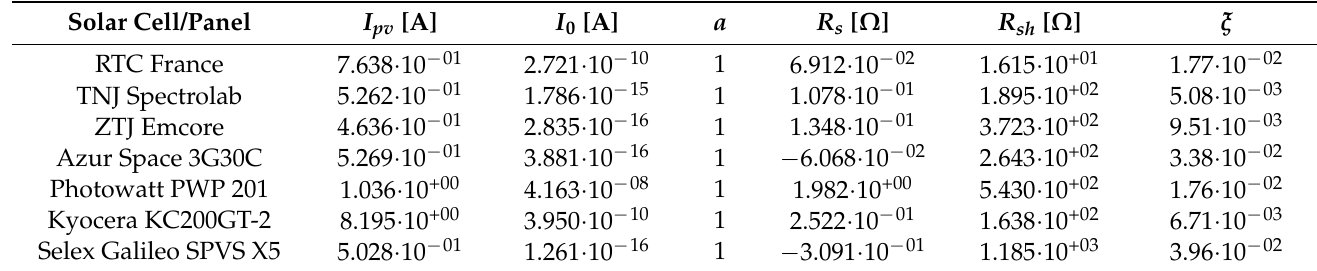
Figure 7. Values for the non-dimensional RMSE, x , obtained from a numerical fit of the 1-D/2-R equivalent circuit model to the studied I-V curves (see Table 2), an analytical fit (see Table 3), and an analytical fit with a = 1 (see Table 4). Table 4. Analytically fitted parameters for 1-D/2-R equivalent circuit models, with a = 1, for I-V curves corresponding to RTC France, TNJ Spectrolab, ZTJ Emcore, and Azrur Space 3G30C solar cells, and Photowatt PWP 201, Kyocera KC200GT-2, and Selex Galileo SPVS X5 solar panels (where ξ is the non-dimensional RMSE for the